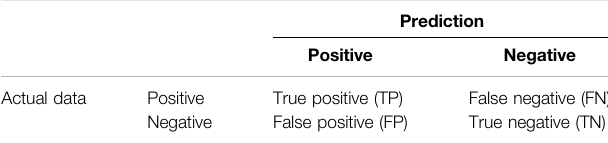
TABLE 1 | Confusion matrix for evaluation of the discrimination/classi fi cation